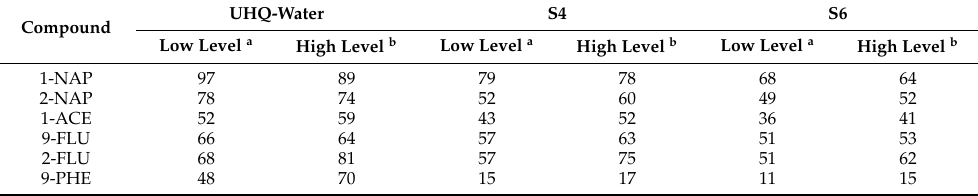
Table 5. Mean recovery values (%) obtained in UHQ-water and two different spiked urine samples (S4 and